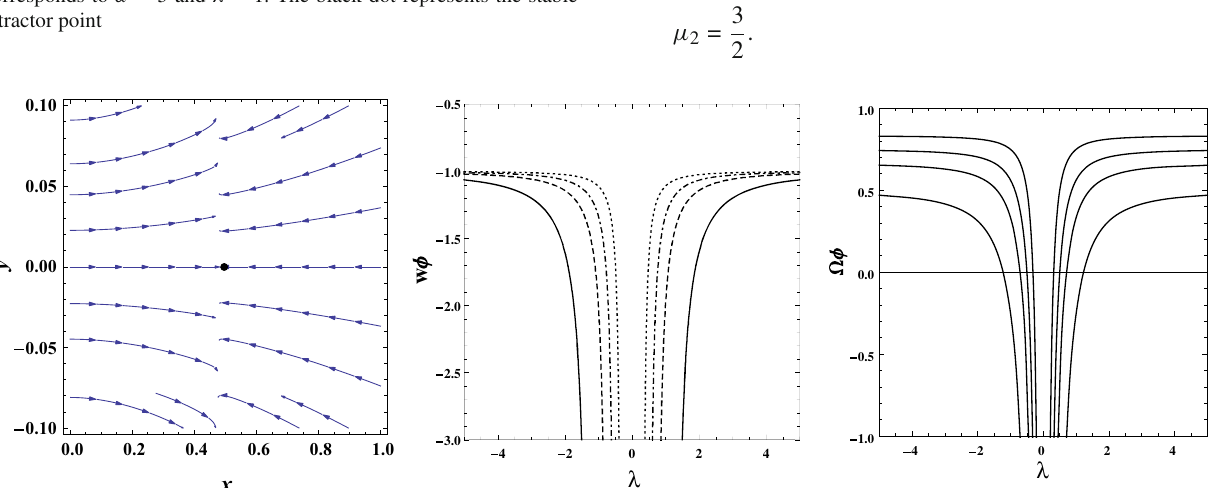
Fig. 1 The figure shows the phase space trajectories for point (3) of the coupling Q = α ˙ ρ m . The stable fixed point is an attractive node and corresponds to α = 5 and λ = 1. The black dot represents the stable attractor point